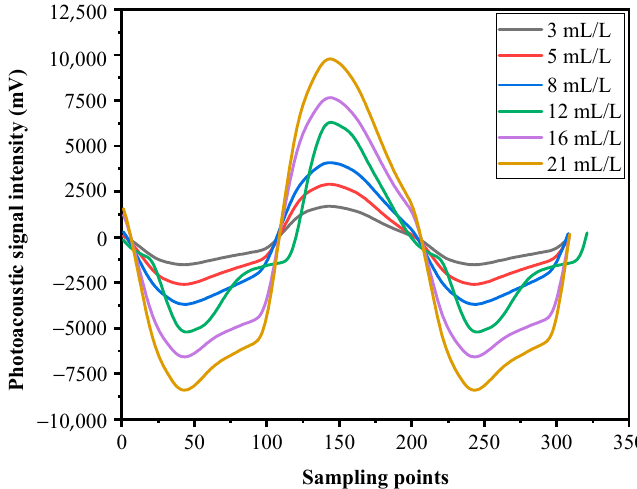
Figure 8. Photoacoustic signals at different concentrations.